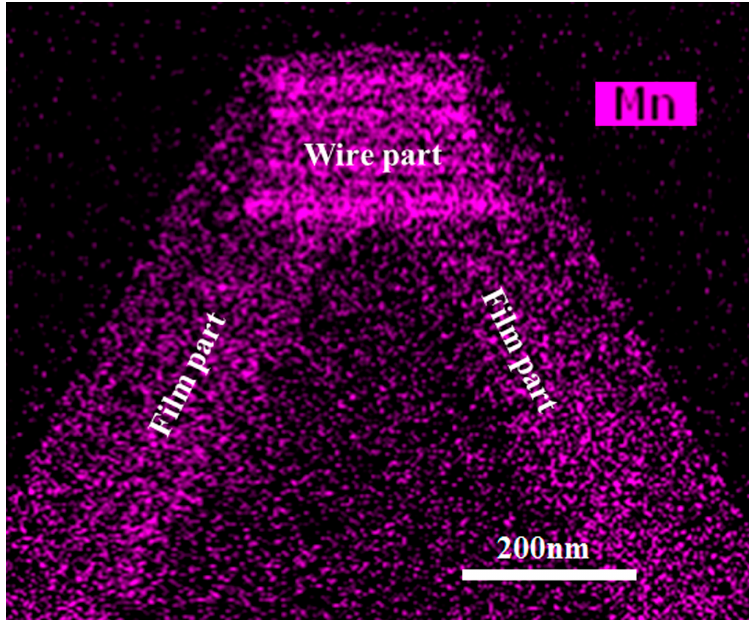
Figure 2. The cross-section energy dispersive spectroscopy (EDS) mapping image of the upper part of one ridge.